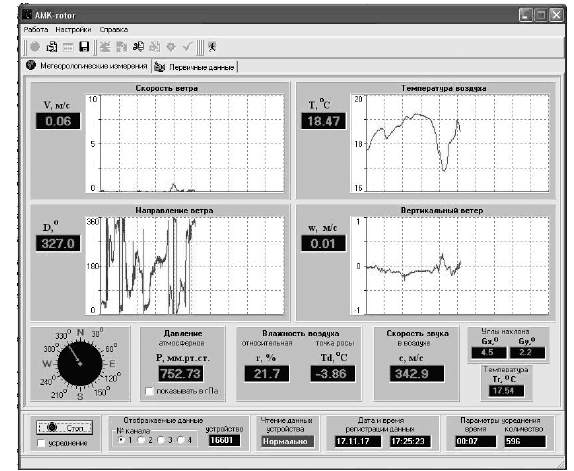
Figure 4. Main window of the “AMK-rotor” program.